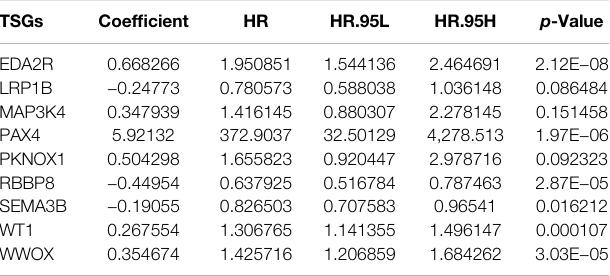
TABLE 1 | Coef fi cients of nine tumor suppressor genes (TSGs) in the multivariate Cox regression model. TSGs Coef fi cient